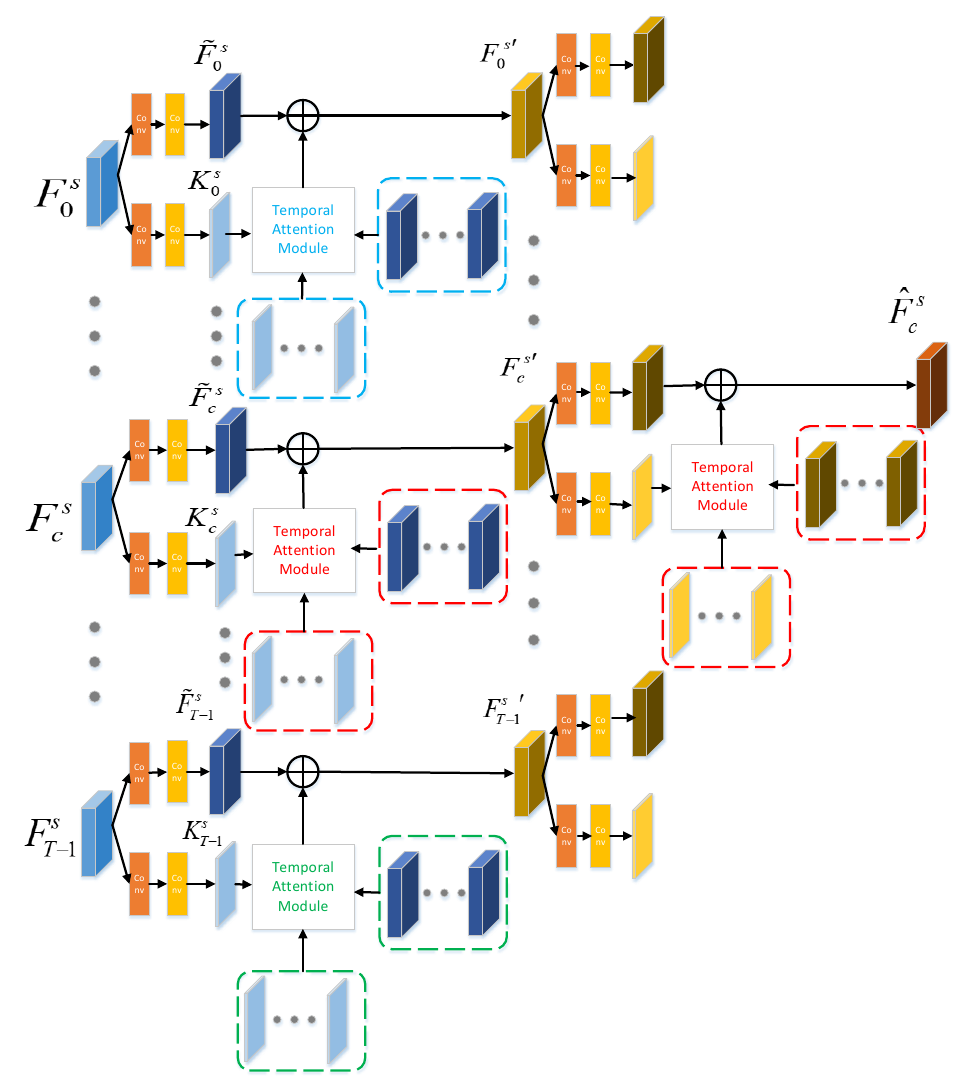
Figure 3. Temporal Consistency Enhancement